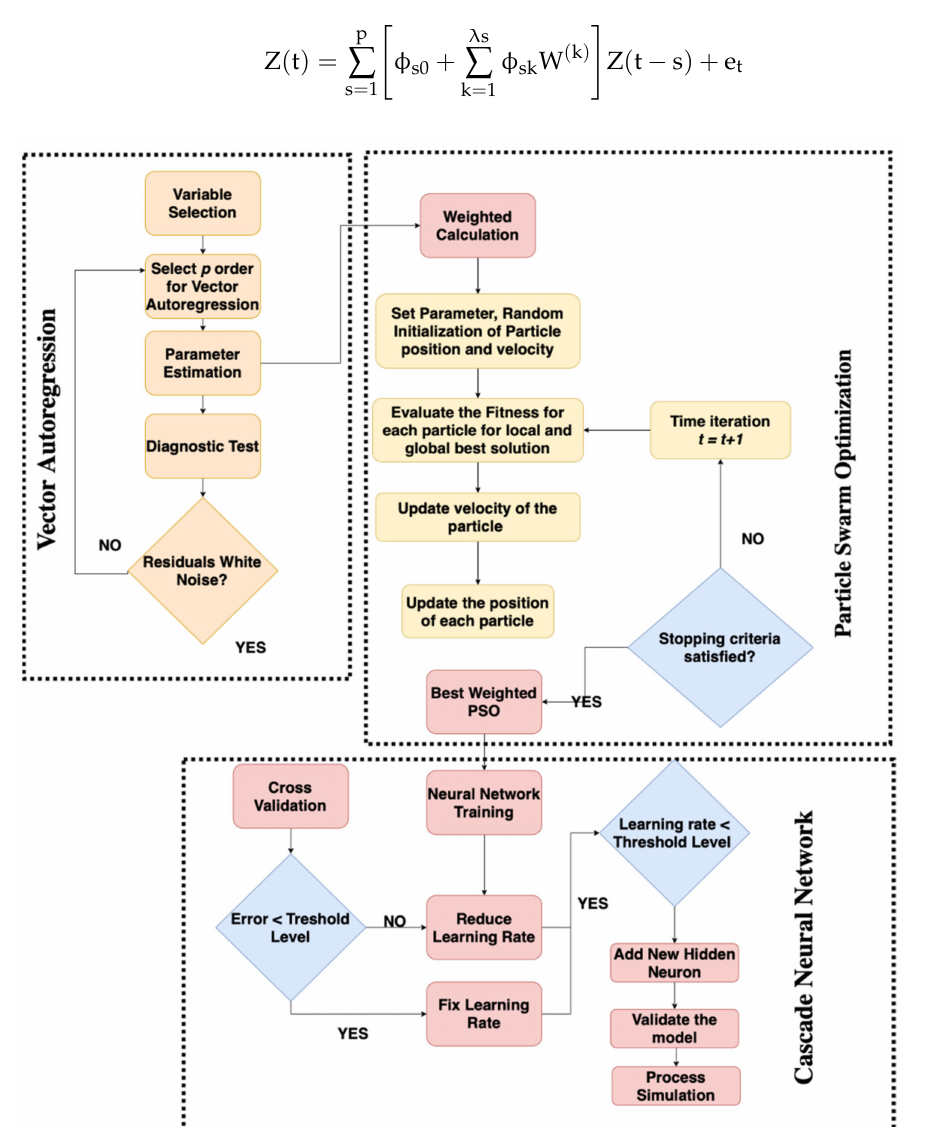
Figure 1. Flowchart VAR-CASCADE NN